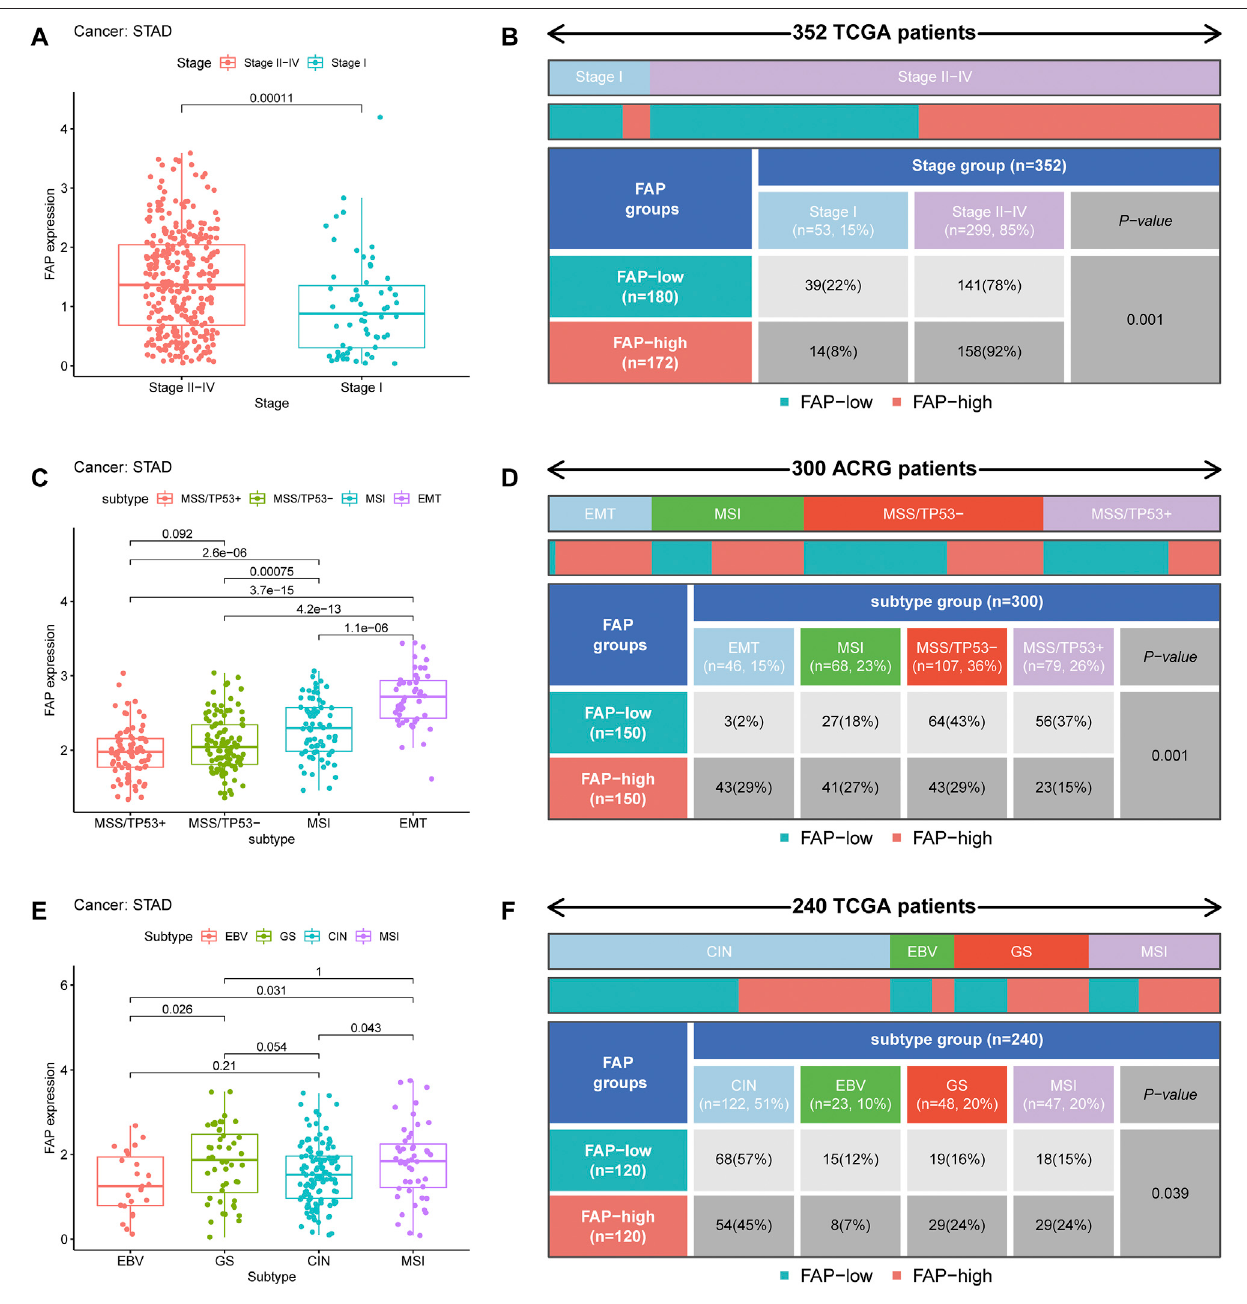
Frontiers in Cell and Developmental Biology |